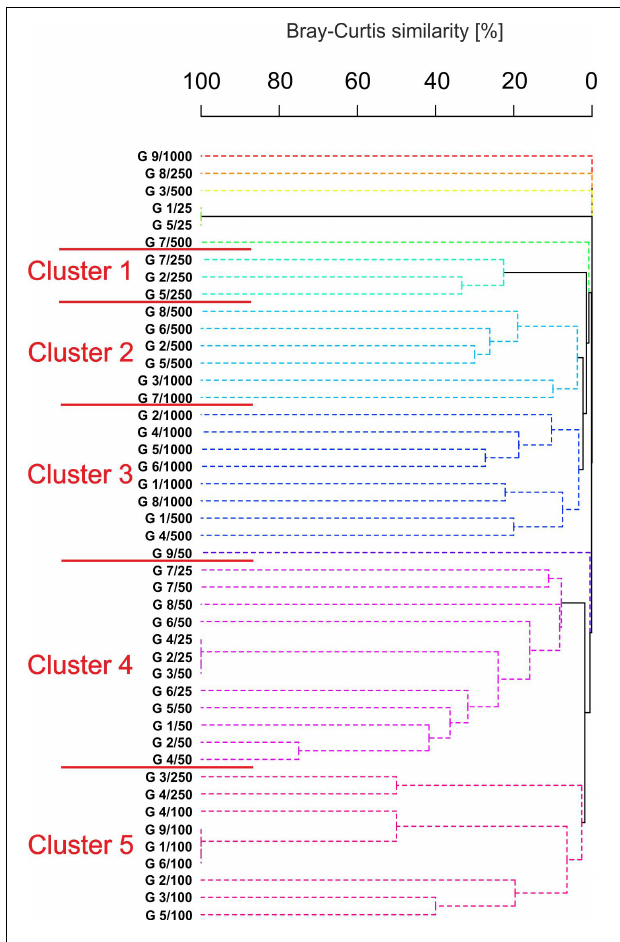
FIGURE 8 | Dendrogram of samples for Bray Curtis similarity, square root transformed data, and group average grouping method with 1,000 iterations. (Spotted lines indicate the samples that cannot be significantly differentiated by